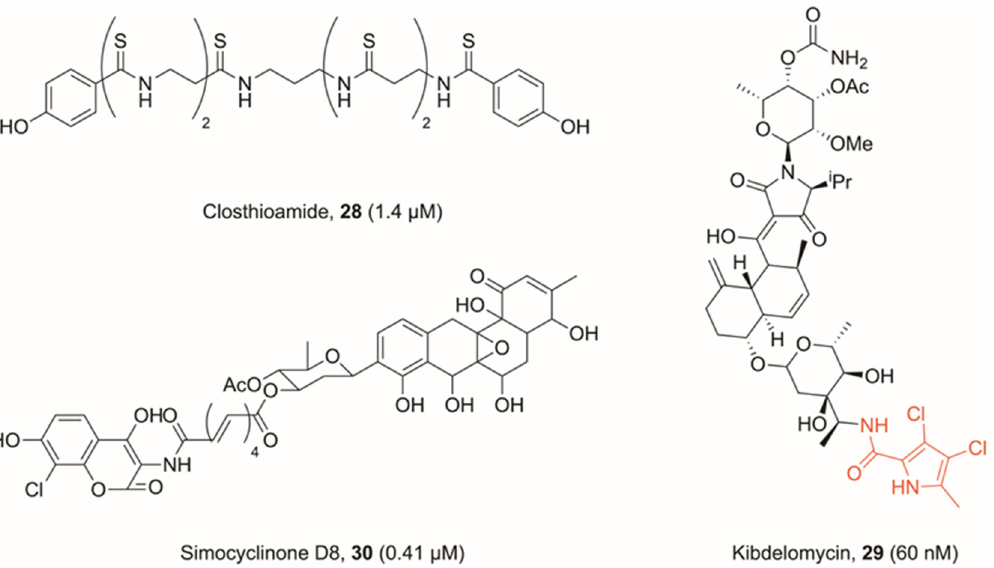
Figure 9. Bacterial topoisomerase inhibitors displaying unique or unusual modes of inhibition, with IC 50 values against E. coli DNA gyrase in brackets. Closthioamide and kibdelomycin are ATPase inhibitors, though display different modes of inhibition to known ATPase inhibitor novobiocin. Simocyclinone D8 is further found to bind to a region of GyrB; hence, it displays a novel mechanism of action where it is capable of interacting with two regions of DNA gyrase simultaneously.